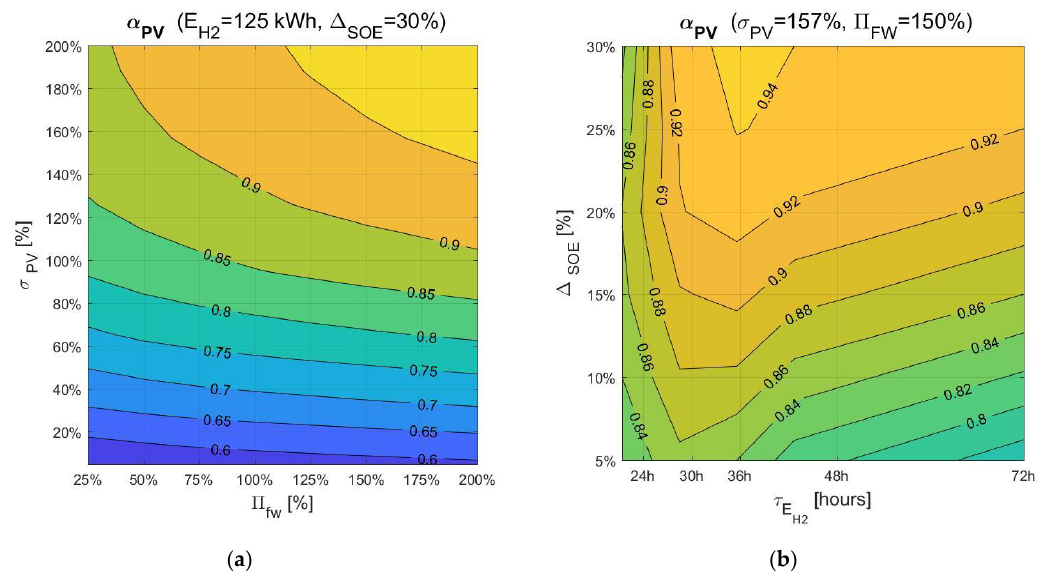
Figure 8. Sensitivity analysis of the key performance indicator 𝛼 𝑃𝑉 scored for the best mini-grid configuration reaching energy optimization. 𝛼 𝑃𝑉 contour maps are plotted vs: ( a ) σ PV and Π FW , for constant value of 𝜏 𝐸 and Δ SOE ; ( b ) versus 𝜏 𝐸 and Δ SOE, for constant value of σ PV and Π FW.